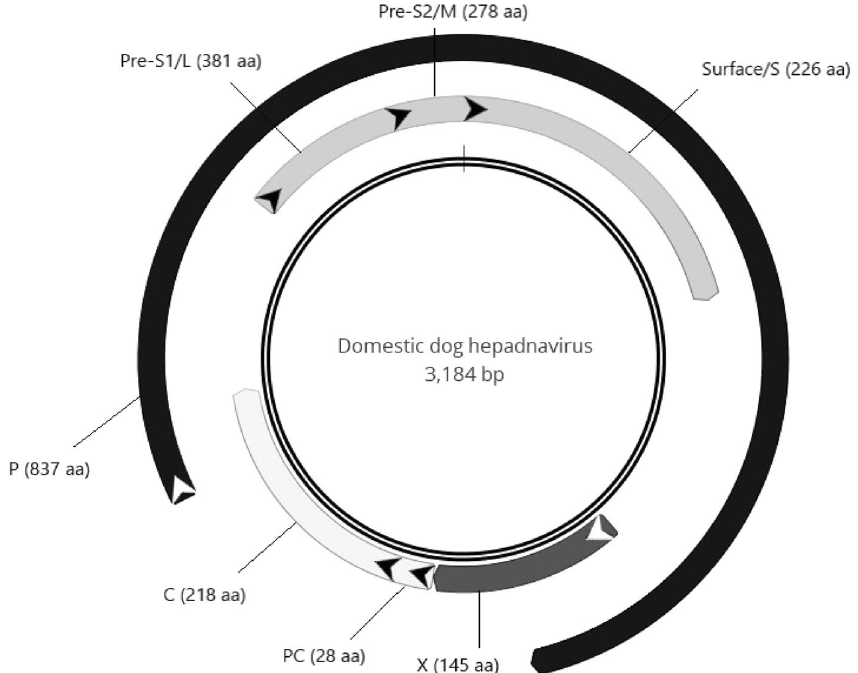
Figure 1. Genome organization of the DDH. The complete genome consists of 3184 bp. The proteins encoded by the polymerase (P), surface (S), core (C) and X ORFs are labelled in grey shades. The predicted Pre-S1/L (large), Pre-S2/M (middle) and Surface/S forms of the S protein are indicated. Also, the Pre-core (PC) region is shown. The length of each protein is indicated in amino acids (aa). The arrows indicate the position of the initiator codons and the ORF